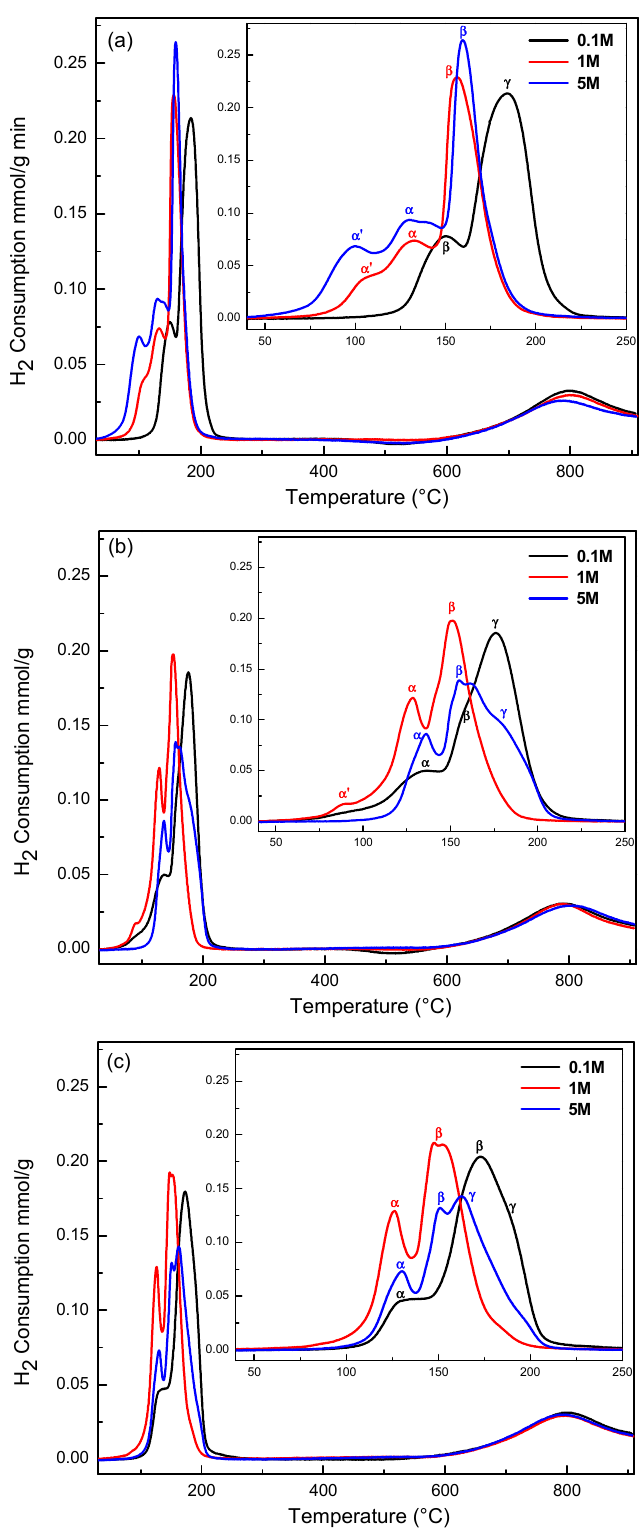
Figure 4. H 2 -TPR profiles of the CuCe oxide catalysts obtained after hydrothermal treatment at 120 °C ( a ), 150 °C ( b ) and 180 °C ( c ). Magnification of the low temperature region is shown in the inset profiles.